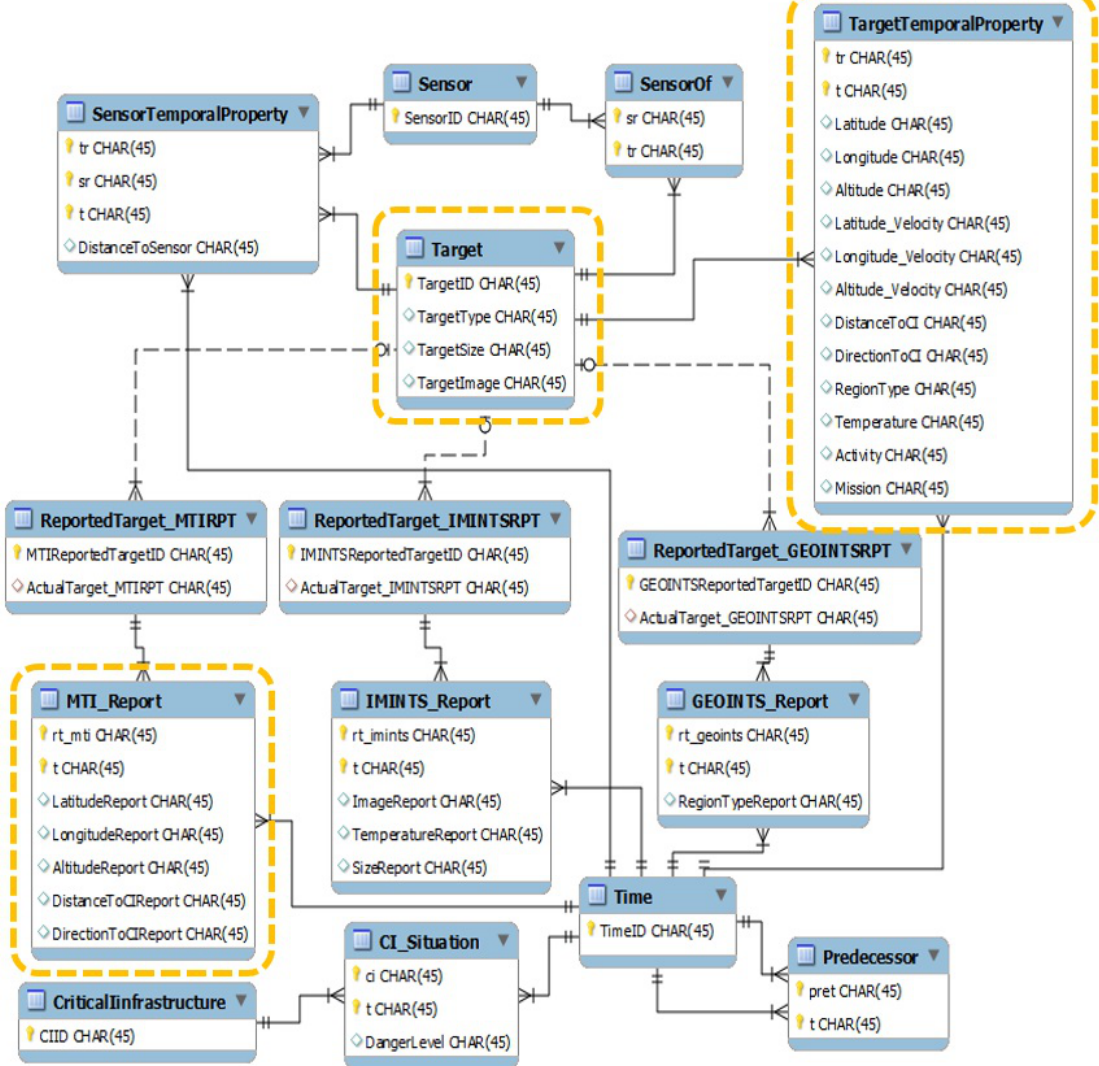
Figure 4. Partial HERALD Relational Database